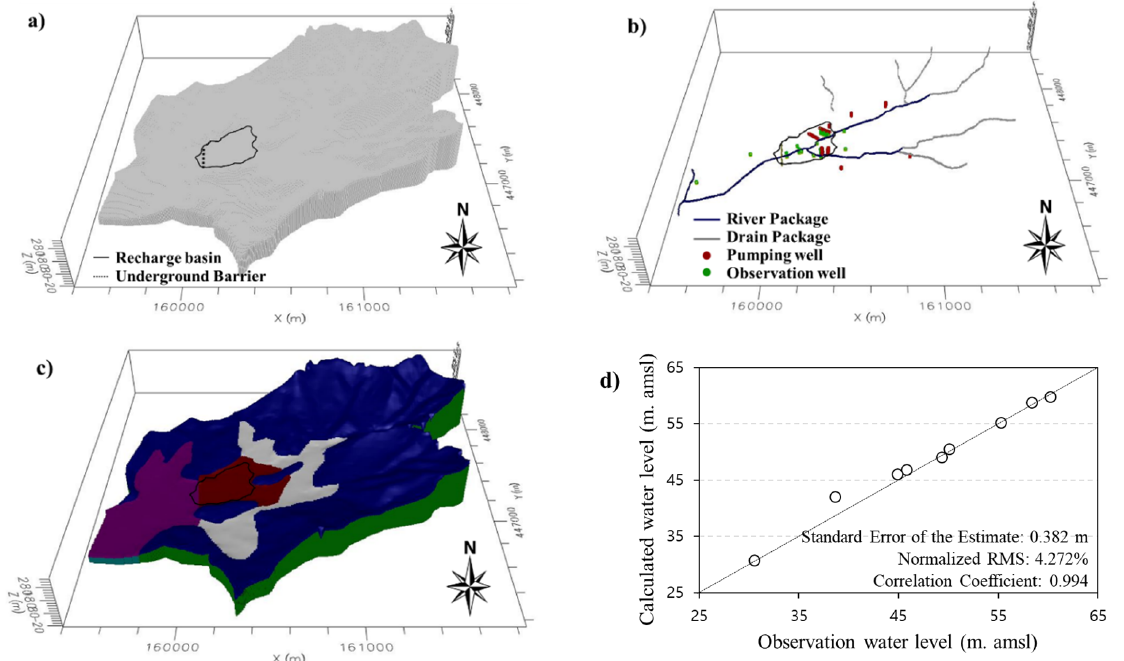
Figure 3. ( a ) Groundwater injection rate along recharge lines and ( b ) groundwater level at the mon- itoring wells during artificial recharge period.